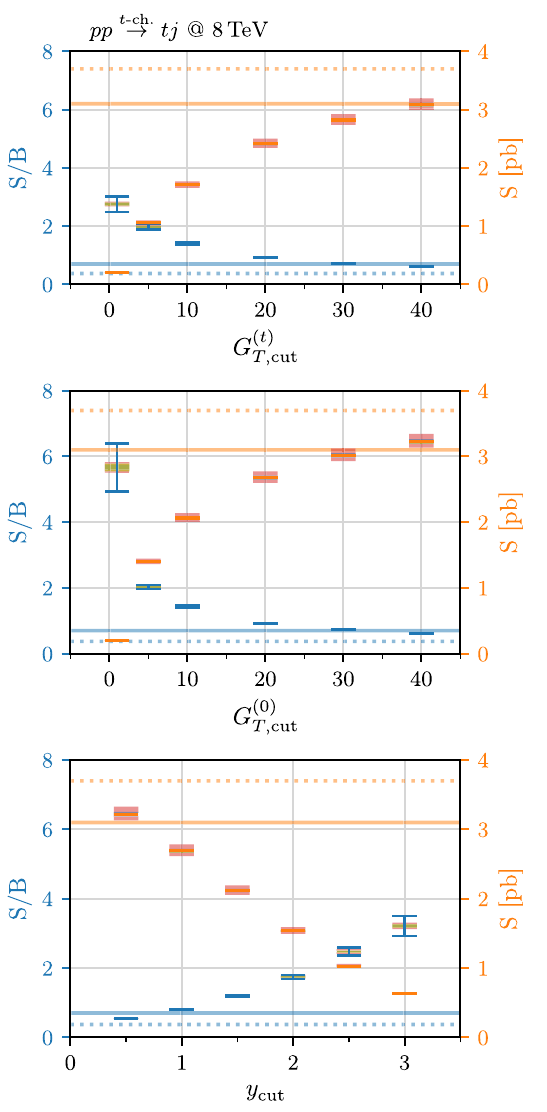
Fig. 6 Signal-over-background ratios for different cut alternatives to the N l-jets = 1 requirement in the fiducial phase space definition as described in Sect. 3. The signal is t -channel single-top production, the background consists of the sum over t ¯ t and W jb production. Scale uncertainties are included only for the signal in the S / B ratios. PDF